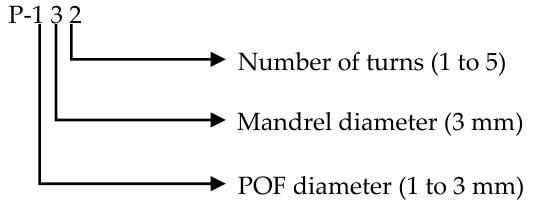
Figure 4. Explanation of the sensor probe coding used in this work.